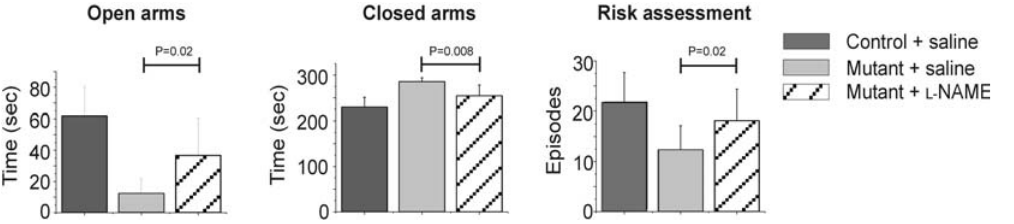
Figure 9. Mutant mice exhibit increased in stress-related parameters on the Elevated Plus maze. Control mice (n=13, dark gray bars) were compared to mutant mice (n=10, light gray bars) on the Elevated Plus maze. The time spent in the open or closed arms was measured. Risk assessment designates the combined number of stretch/attend postures and head dipping episodes. Systemic injection with the NOS inhibitor L- NAME (50 mg/kg i.p., n=10) 10 hours prior to testing improved the performance of mutant mice on the Elevated Plus maze, resulting in significant differences between them and saline-injected animals (n=11). Control animals were injected with saline only (n=11), and their motor behavior was not significantly different from non-injected animals.